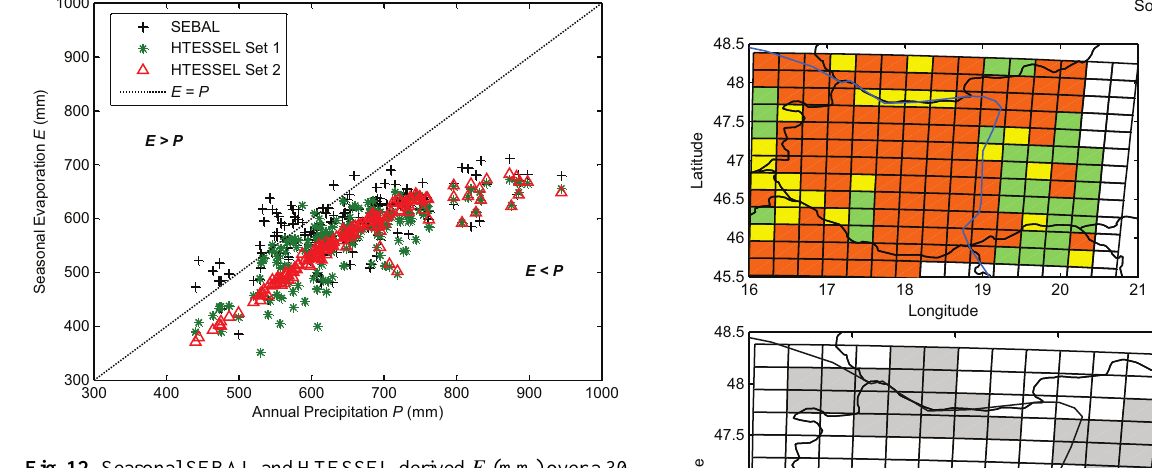
Fig. 12. Seasonal SEBAL and HTESSEL derived E (mm) over a 30 week period starting at week 13 and ending at week 43, 2005 and annual TRMM precipitation ( P , mm) over 2005 for each grid cell in the test region. Each symbol represents one grid cell. The dotted line E = P and SEBAL E are given for reference. Like Fig. 6, the figure shows a correlation between P and E , especially for Set 2. For both initial condition sets the transition between precipitation dominated E and radiation dominated E is clearly visible.